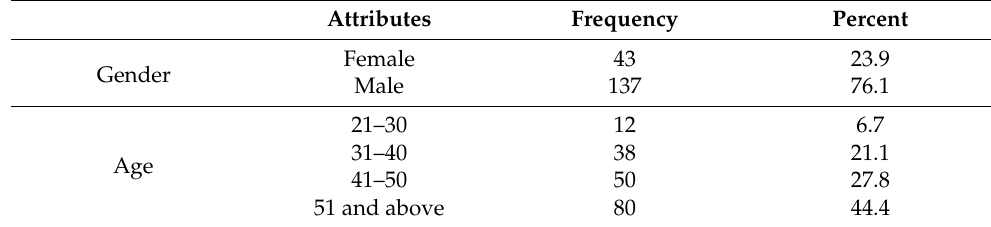
Table 3. Demographics for the survey